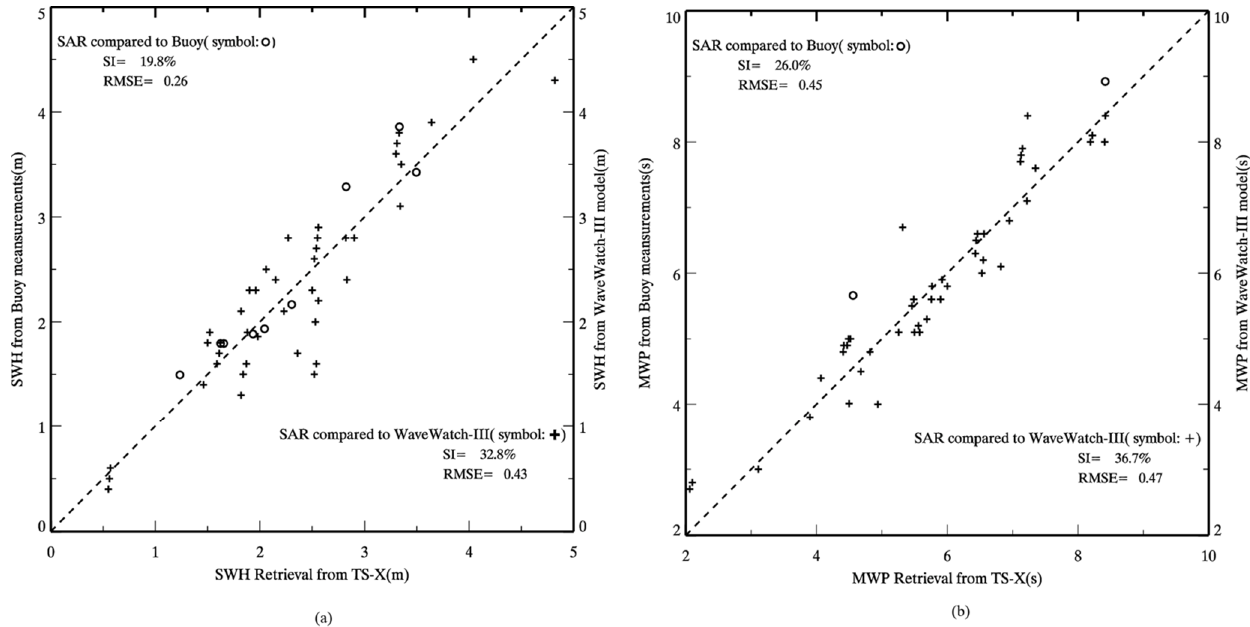
Figure 5. Wave parameters retrieval results from HH-polarization TS-X images are compared to buoy measurements in Table 2 and all TS-X images are compared to computation from the WAVEWATCH-III model: ( a ) SWH comparison and ( b ) MWP